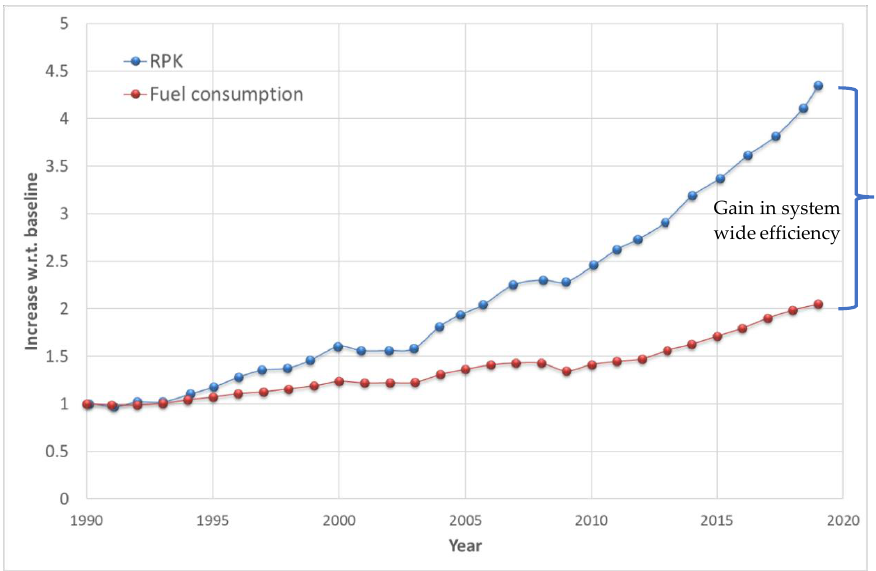
Figure 4. Increase in global revenue passengers-km (RPK) and fuel consumption for civil aviation (sources: Statistica, International Civil Aviation Organization (ICAO), IATA).